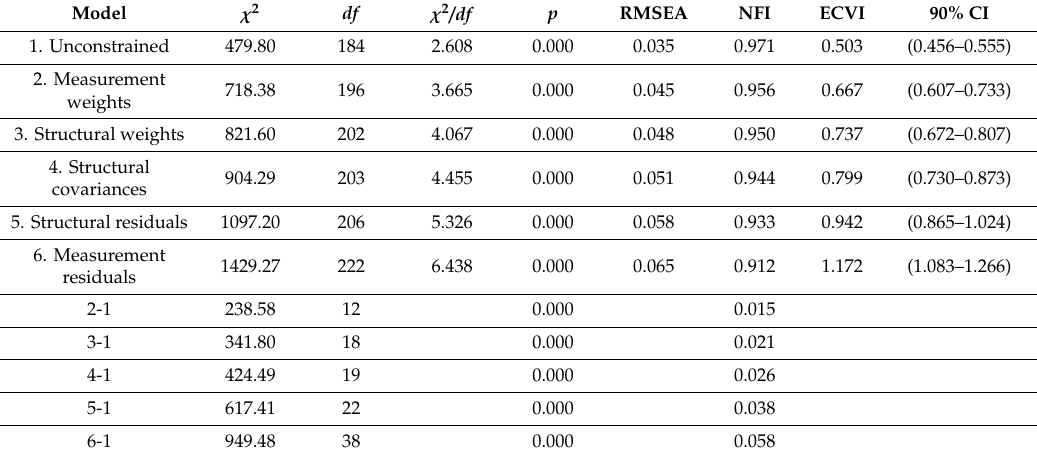
Table 4. Multi-group